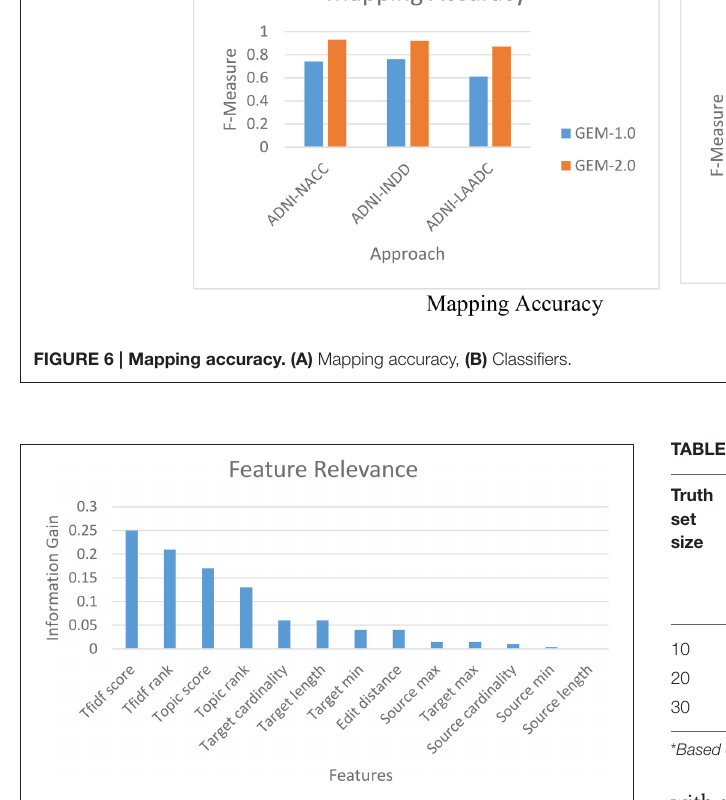
FIGURE 7 | Feature relevance.